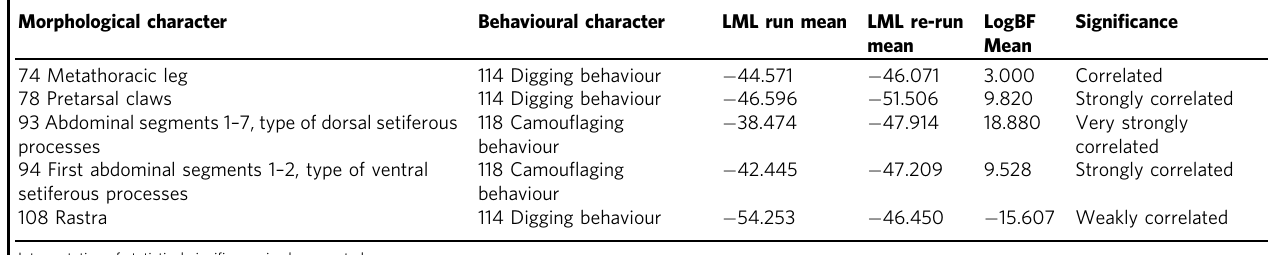
Table 1 Results of statistical correlation analyses between selected morphological and behavioural traits calculated from the mean values of the MCMC (LML) chains, repeated for 20 times, using Log Bayes Factor